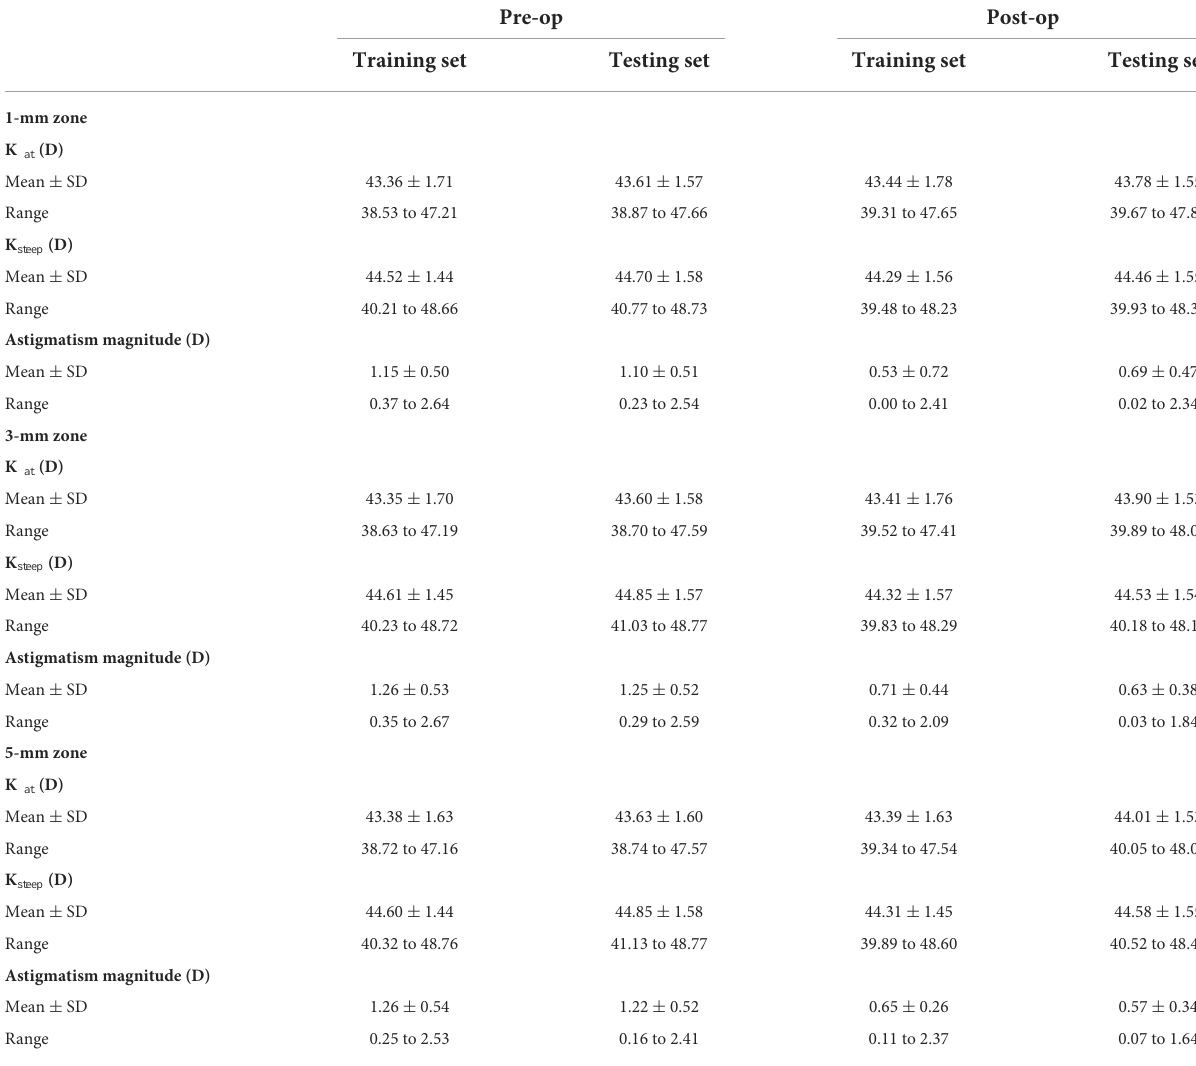
TABLE 2 Distribution of preoperative and postoperative astigmatism in different zones of the cornea in the training and test sets. Pre-op Post-op Training set Testing set Training set Testing